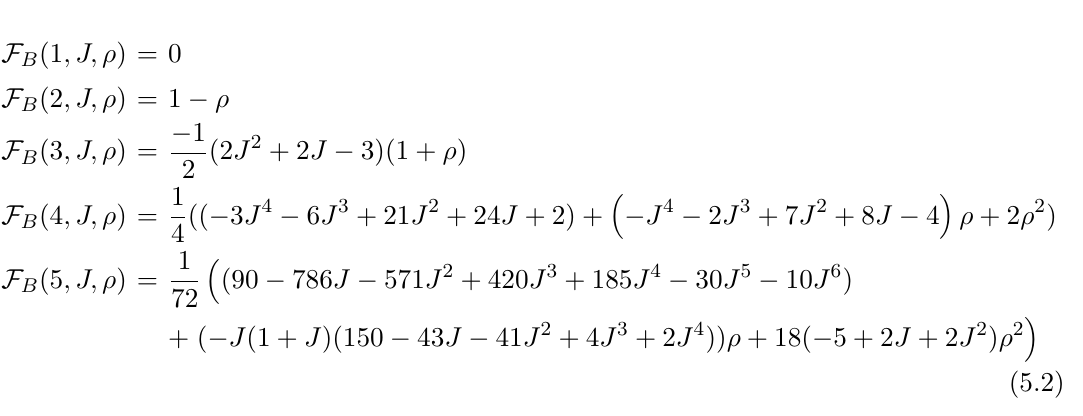
( n ) and J ≥ J ( n ) corresponding to negative c c